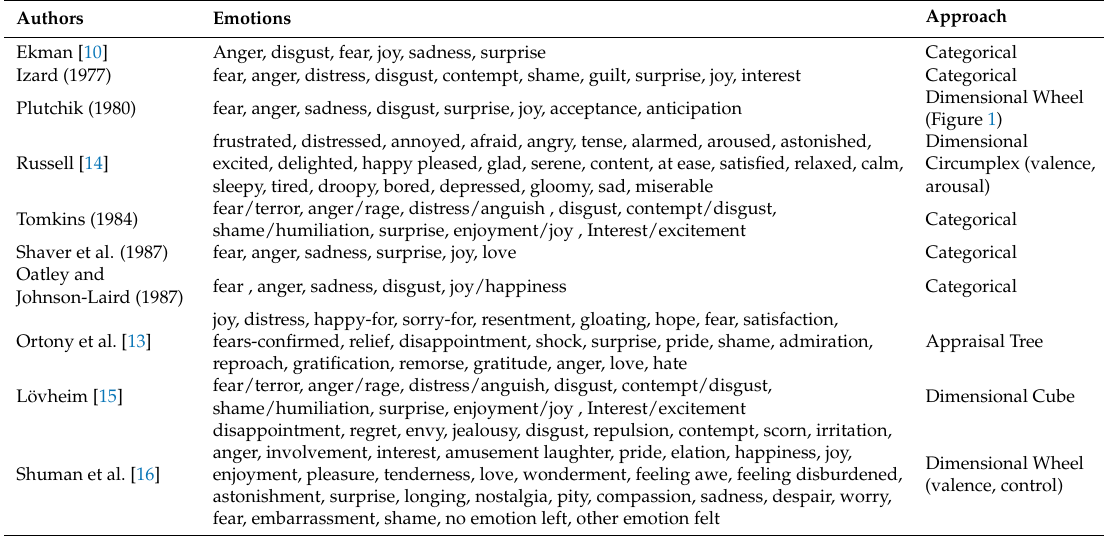
Table 1. Listing emotion models and their appertaining